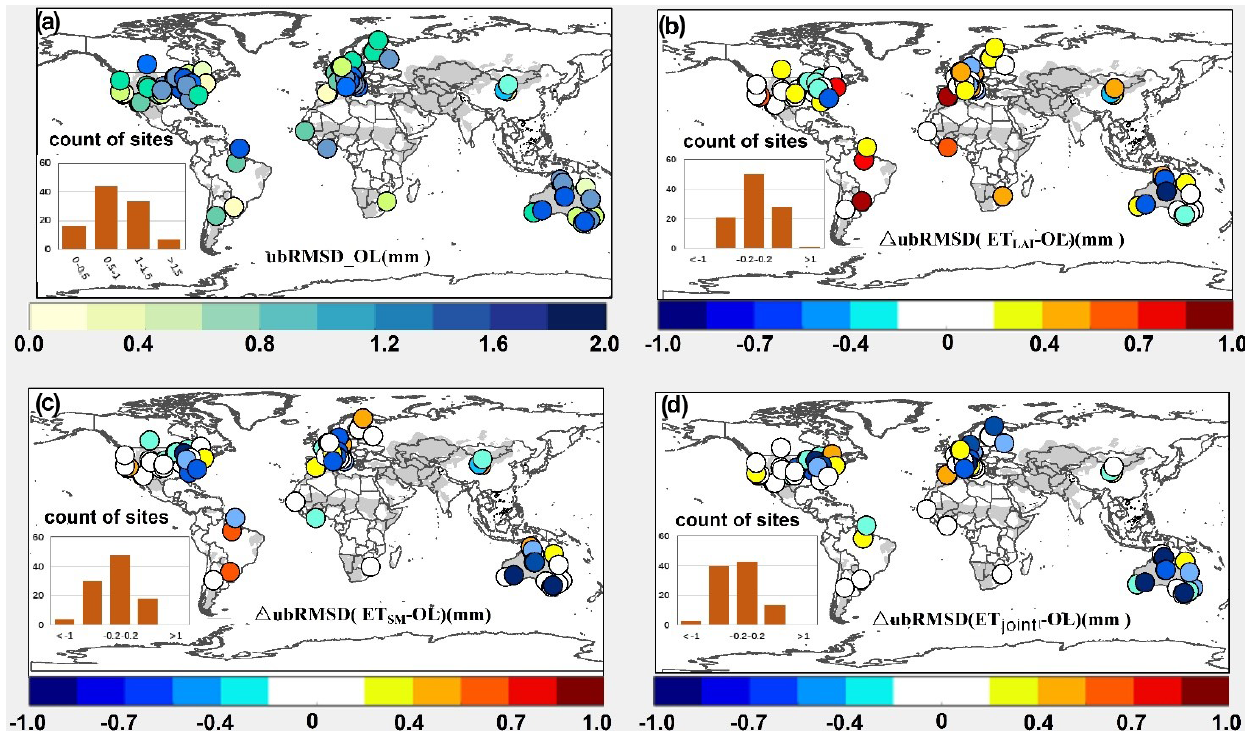
Figure 5. (a) The unbiased root mean square error (ubRMSE) between the ET simulated by the LPJ-DGVM and the site observations, with yellow/blue indicating low/high ubRMSD. (b) (cid:49) ubRMSD (ET LAI –ET LPJ ). (c) (cid:49) ubRMSD (ET SM –ET LPJ ). (d) (cid:49) ubRMSD (ET Joint – ET LPJ ). Blue/red represents positive/negative